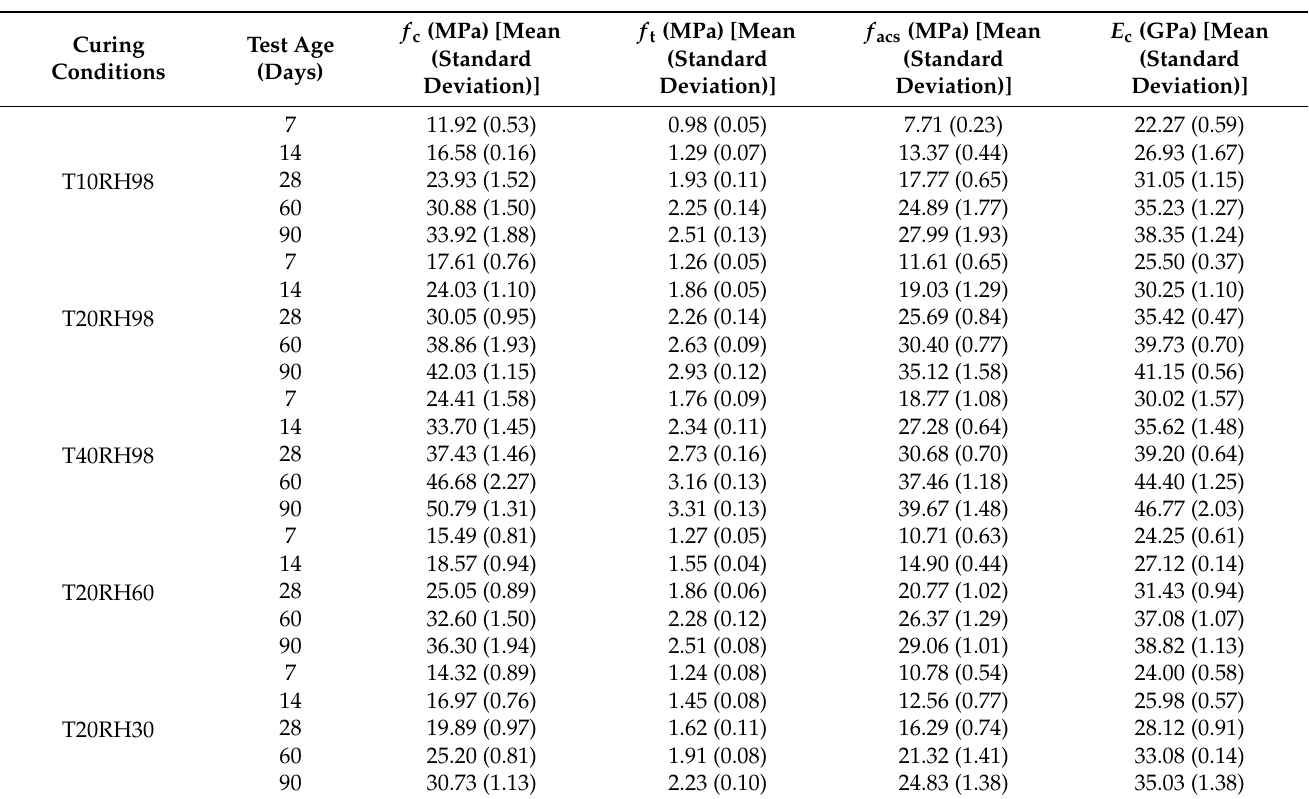
Table 4. Strength test results of environmental chamber-cured concrete at different temperatures and